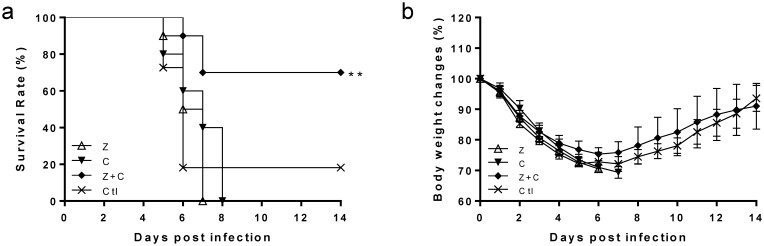
Survivals and body weight changes of mice treated with combination of zanamivir and celecoxib, zanamivir or celecoxib alone by intraperitoneal injection.The mice were infected with 106 PFU of CK1 and treated with (1) combination treatment (♦): celecoxib 2 mg daily from day 2 to day 4 p.i., and zanamivir 2mg twice daily from day 2 to day 8 p.i; (2) zanamivir alone (Δ): zanamivir 2mg twice daily from day 2 to day 8 p.i; (3) celecoxib alone (▾): celecoxib 2 mg daily from day 2 to day 4 p.i., (4) control group (×): Celecoxib solven (1% DMSO/PBS) 200ul from day 2 to day 4 p.i. The survival (a) and body weight change (b) were observed for 14 days after infection. Data shown are the average of two experiments (in total, n = 10 for each treatment group, n = 17 for control group). *P<0.05 as compared to untreated control group.